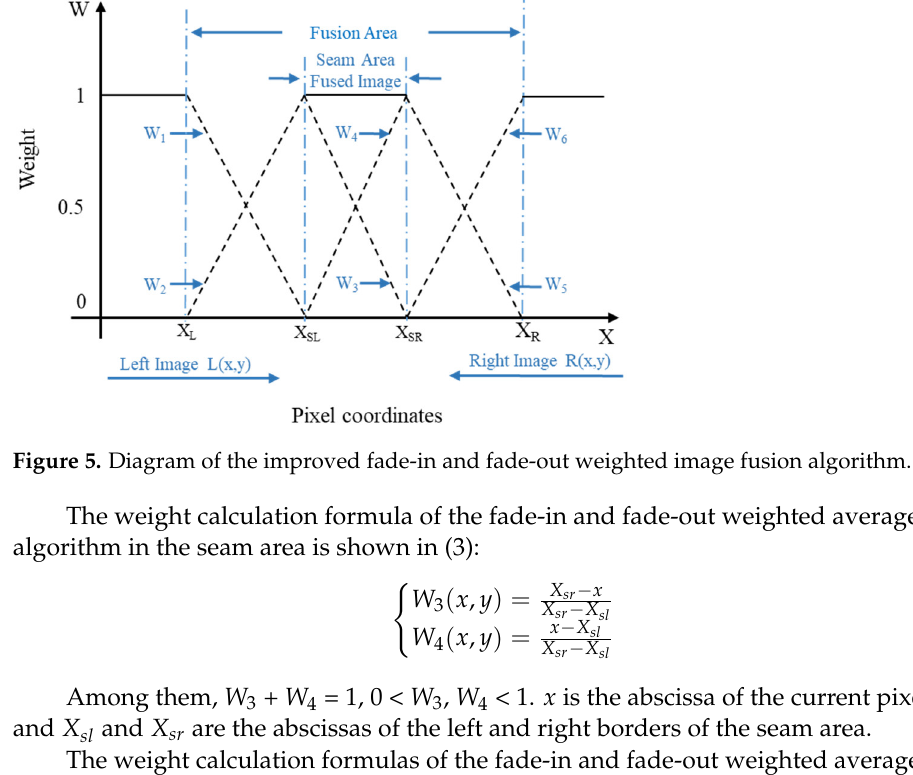
8 of 20 Figure 4. The schematic diagram of the fusion area’s construction. After the optimal seamline was obtained, the area to be seamed was first fused indi- vidually. Thus, the pixels that needed to be calculated came from the image on the left, right, and seam area fused. The weight coefficient calculation formula of the weighted average fusion method was improved in accordance with the various pixel coordinate positions in the different areas, which were fused to perform the fusion in a targeted man-